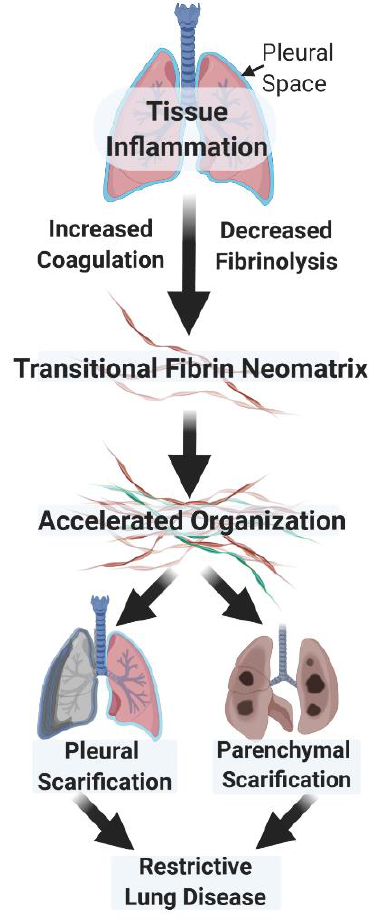
Figure 1. Aberrant fibrin turnover leads to accelerated scarification in the lung or pleural space. The accelerated organization encompasses the invasion of the fibrinous neomatrix by fibroblasts and myofibroblasts, which secrete collagen and initiate fibrotic repair. The neomatrix undergoes continuing remodeling with infiltration by inflammatory cells, including macrophages. Parenchymal lung scarification can be accelerated after acute lung injury or occur more slowly in interstitial lung disease. Pleural scarification can occur with organization, leading to sequestration of pockets of inflammatory pleural fluid; loculation, which can lead to pleural scarification. Pleural fibrosis may also occur after intrapleural bleeding or particulate exposures, such as that due to asbestos. Brown strands indicate fibrin. Green strands indicate collagen intercalated within the fibrinous neomatrix.